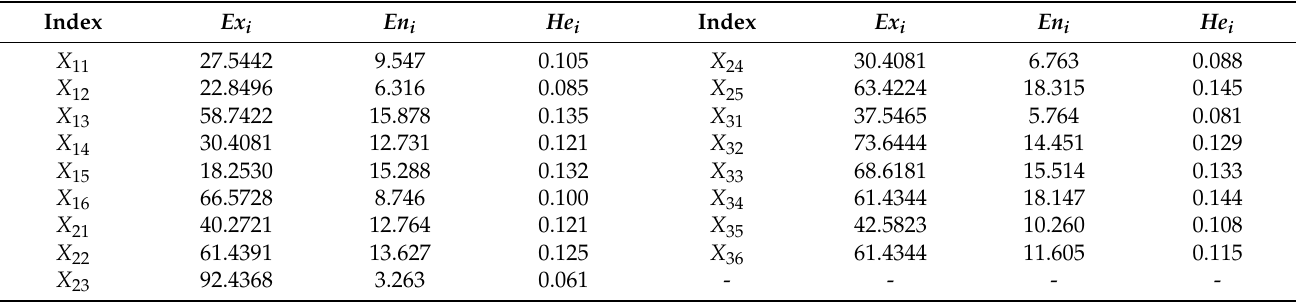
Table A6. Cloud model parameters of secondary indexes.